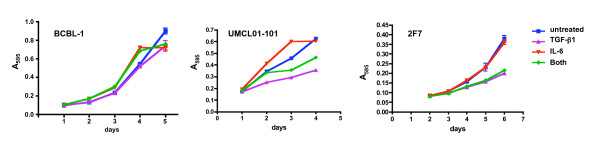
Positive and negative growth regulation of AIDS-NHL cell lines by TGF-β1 and IL-6. BCBL-1, UMCL01-101 and 2F7 cell lines were cultured with TGF-β1 (1 ng/ml), IL-6 (20 ng/ml), both, or were untreated. Cell viability was quantified at daily intervals thereafter using a tetrazolium dye reduction assay.